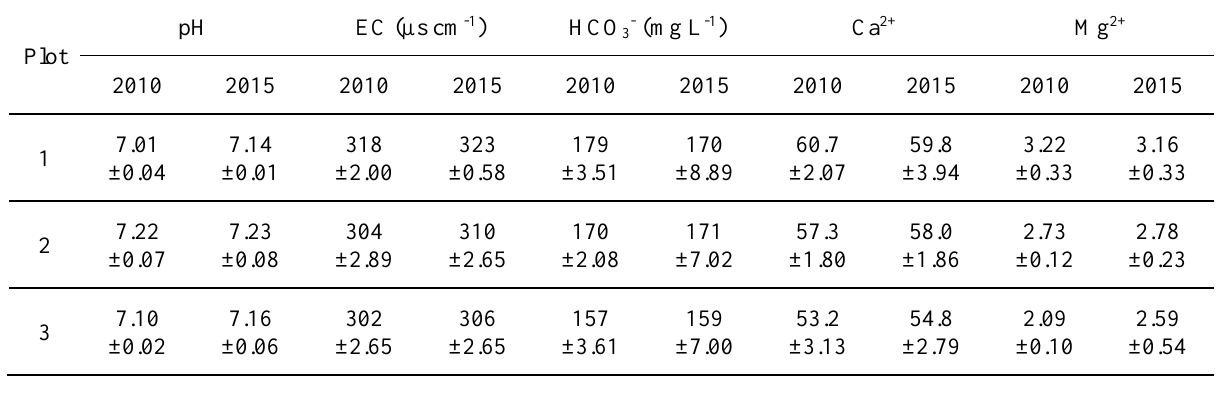
Table 1. Selected chemical properties of peat water (mean values and standard deviation).